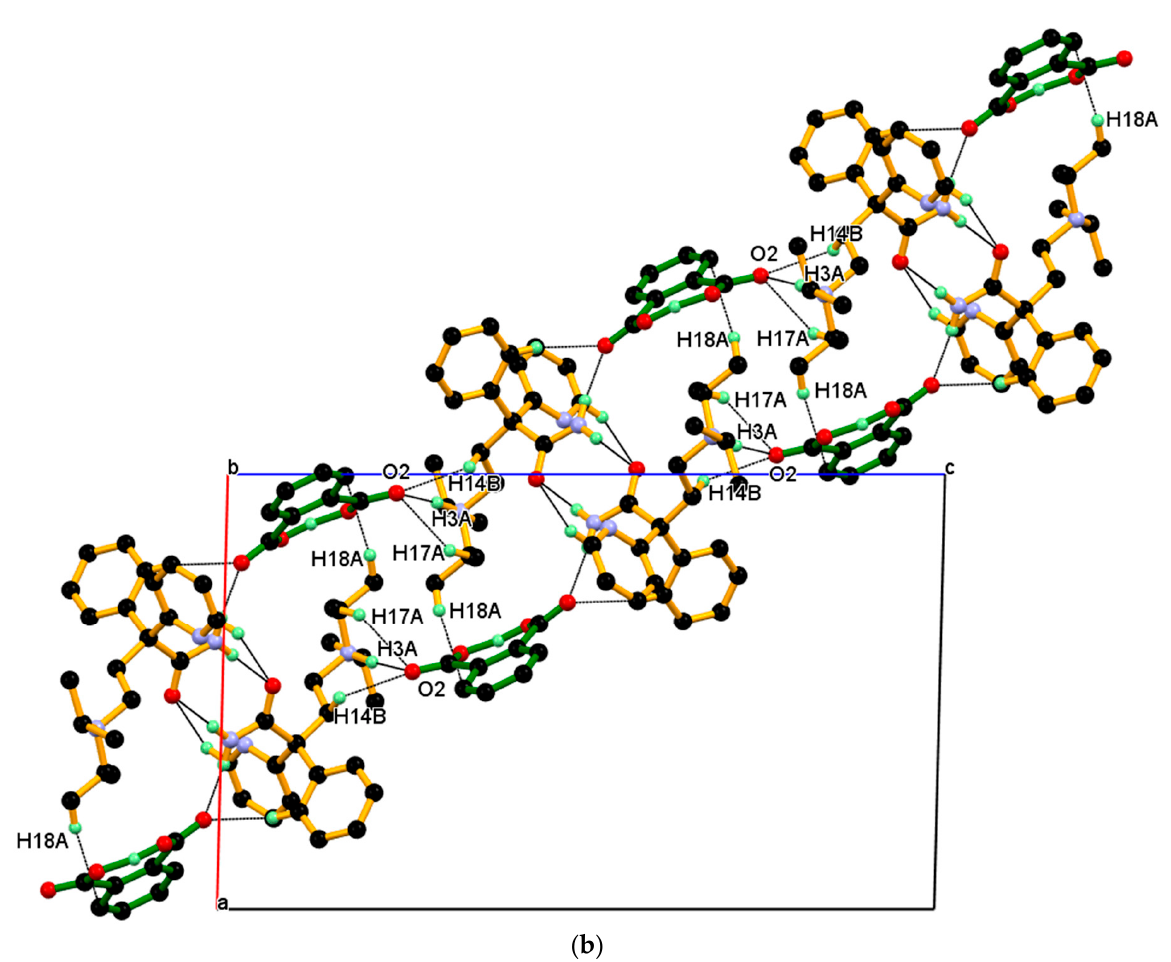
Figure 10. ( a ) Packing view down the a -axis, with each dimeric unit linked to four n -glide related neighboring dimeric units, resulting in 2-D packing (above). The inset shows the association between the neighboring dimeric unit shown in different colors through C2–H2 ∙∙∙ O1 interaction and supported by C18-H18A ∙∙∙ C g 5 along the b -axis. (down) ( b ) Similar packing view in the ac- plane.